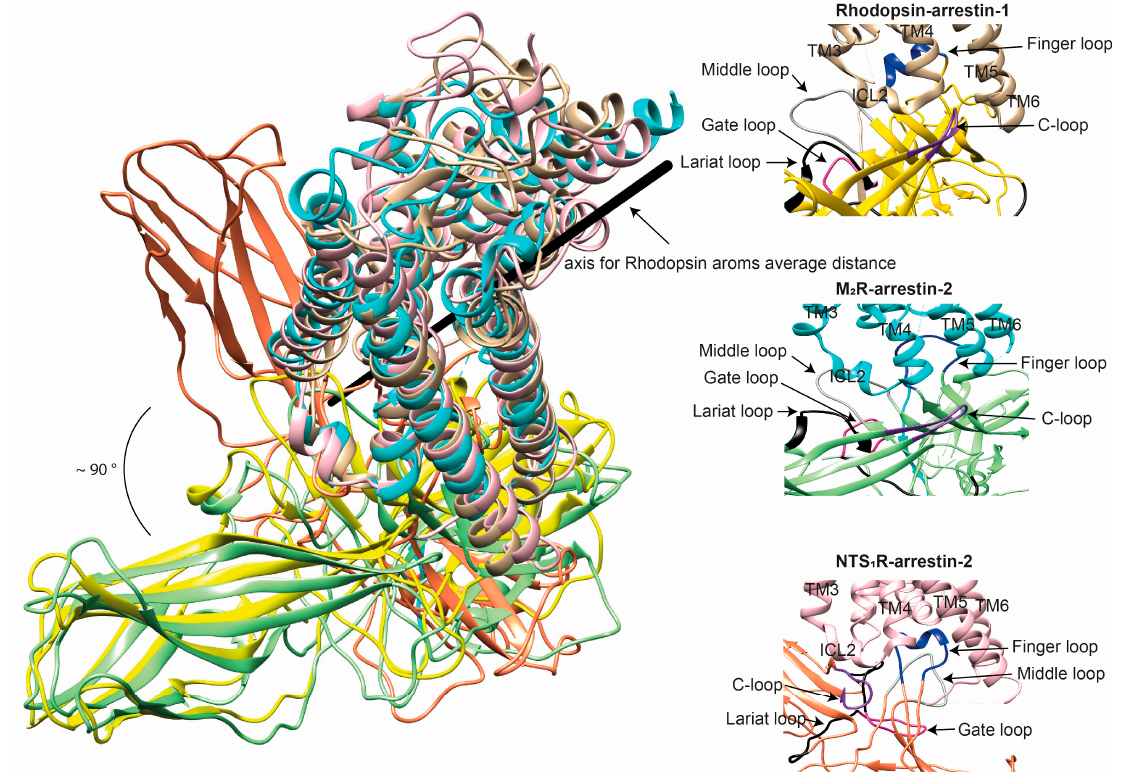
Figure 3. Comparison of the conformations of arrestin ‐ 1 and arrestin ‐ 2 in complex with different receptors. ( Left panel ) The structures of the rhodopsin ‐ arrestin ‐ 1 (PDB: 5W0P [44]), M 2 R ‐ arrestin ‐ 2 (PDB: 6U1N [34]), and NTS 1 R ‐ arrestin ‐ 2 (PDB: 6UP7 [34]) complexes are superimposed according to the best match in receptor sequences, which shows about a 90 ◦ difference in the position of arrestin ‐ 2 in complex with NTS 1 R as compared to the other structures. ( Right panels ) Close ‐ up views of the central crests of arrestins in contact with the receptor are shown for the rhodopsin (tan) ‐ arrestin ‐ 1 (yellow) interface in the upper panel, the M 2 R (cyan) ‐ arrestin ‐ 2 (green) interface in the middle panel, and the NTS 1 R (pink) ‐ arrestin ‐ 2 (orange) interface in the lower panel. The finger (blue), middle (gray), lariat (black), gate (violet), and C ‐ (purple) loops are highlighted to show the difference in the configurations of these elements in the structures.